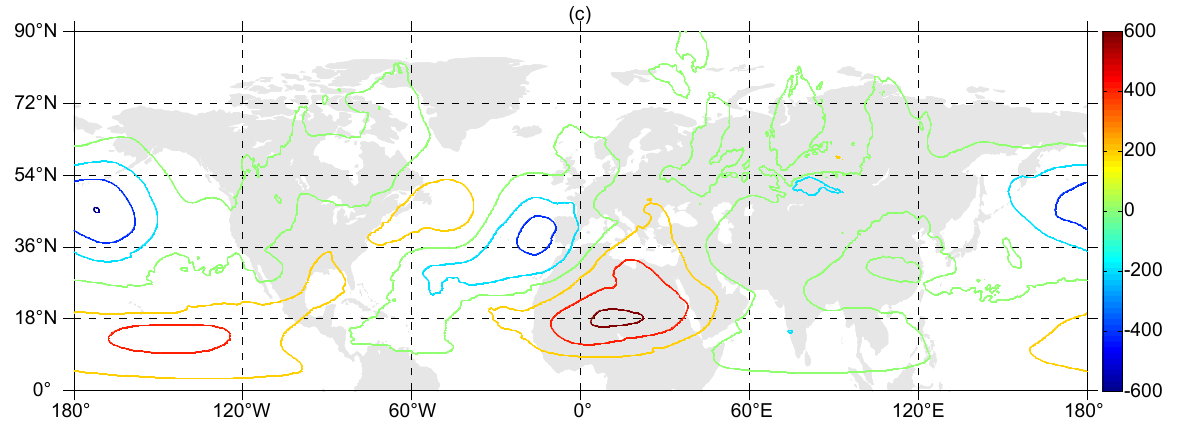
Figure 7. ( a ) Pettitt test statistic for regional mean spring precipitation series in CA; ( b ) the composite anomalous patterns of horizontal wind at 850-hPa; ( c ) patterns for 500-hPa geopotential height between five years of the largest rainfall and five years of the least rainfall. The anomalies were calculated against the mean climatology for 1982–2020.